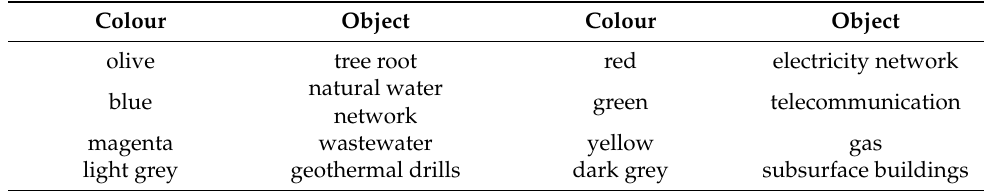
Table 3. Color codes used in Figure 14.